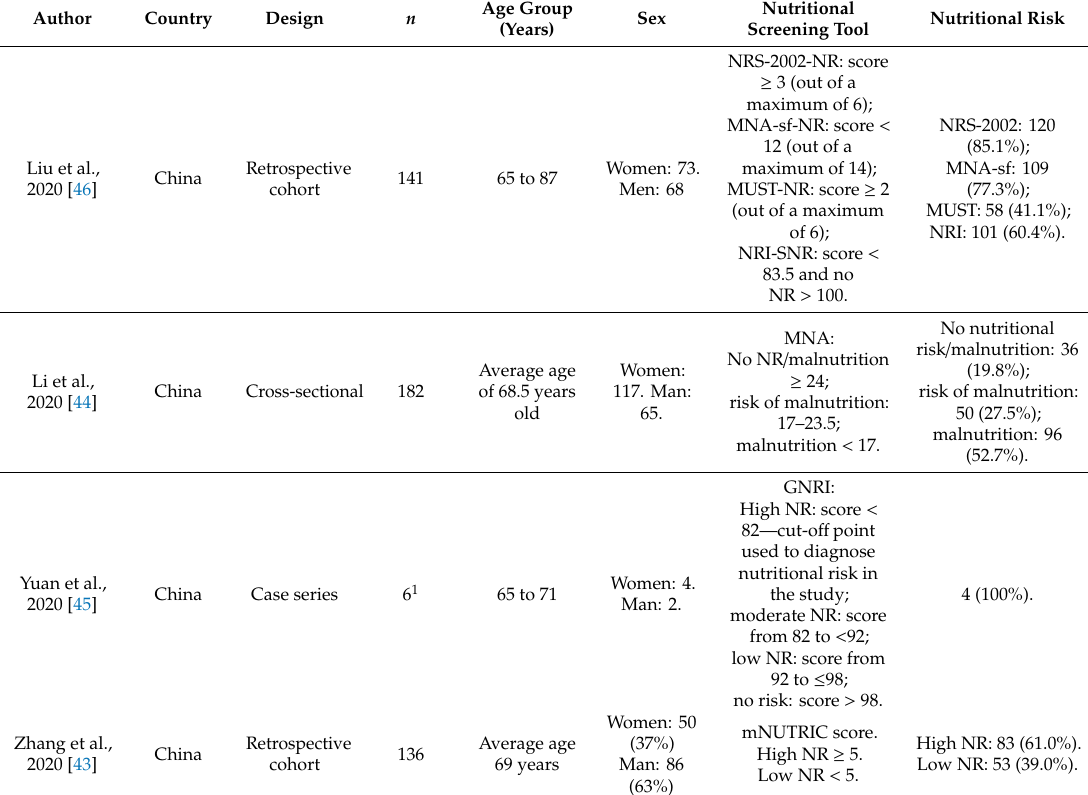
Table 3. Characteristics of participants included in the studies ( n =